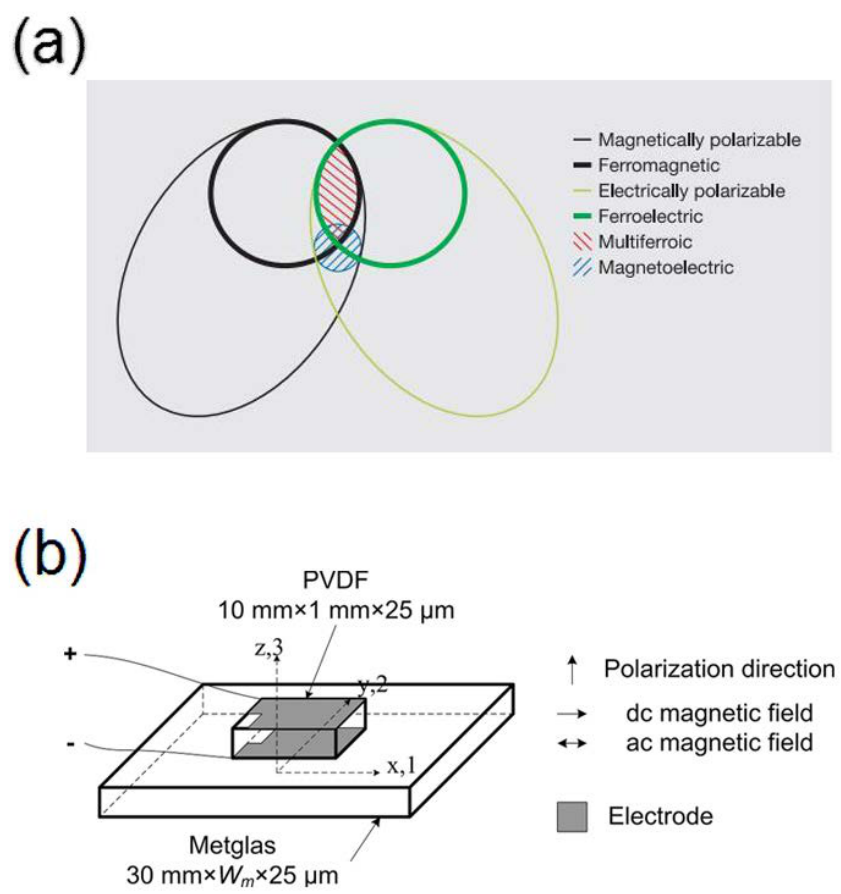
Figure 14. ( a ) The relationship between multiferroic and magnetoelectric materials [157] and ( b ) Diagrammatic sketch of Metglas/PVDF composite laminates [170].